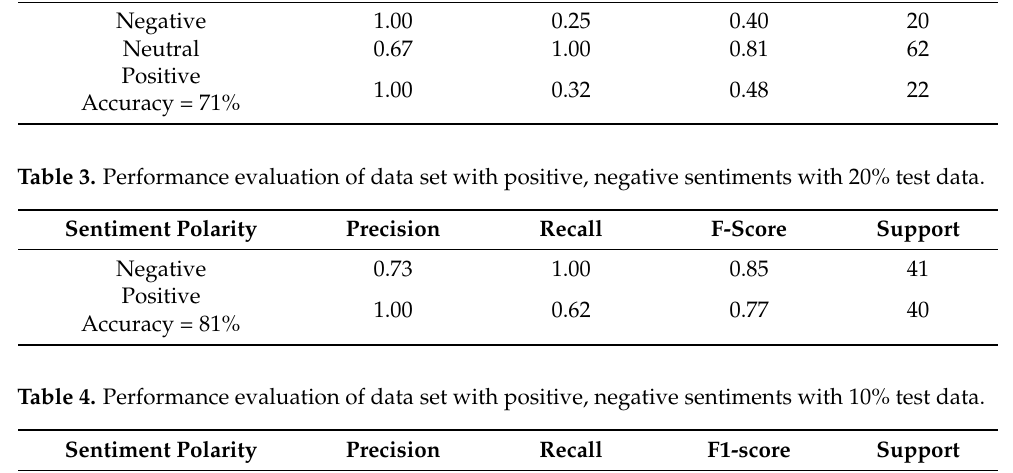
Table 4. Performance evaluation of data set with positive, negative sentiments with 10% test data. Sentiment Polarity Precision Recall F1-score Support Negative 0.85 0.96 0.90 24 Positive 0.93 Accuracy = 87%